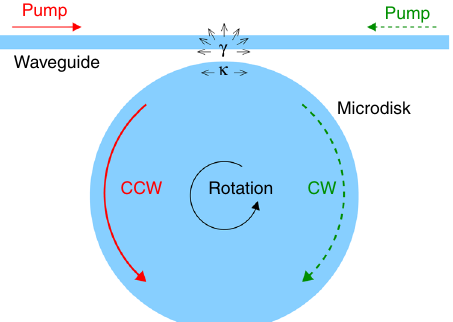
Fig. 2 Simpli fi ed schematic of the Brillouin laser gyroscope in the experiment by Wang et al. 8 . Laser action through the Brillouin process is achieved in an optically pumped microdisk. As required by the Brillouin phase matching condition, the excited laser waves propagate in a direction opposite to the corresponding pump waves. The evanescent coupling to the waveguide causes scattering losses (rate γ ) and backscattering (rate κ ) of clockwise (CW) and counterclockwise (CCW) propagating waves. The waves experience opposite Sagnac frequency shifts used to sense a rotation of the